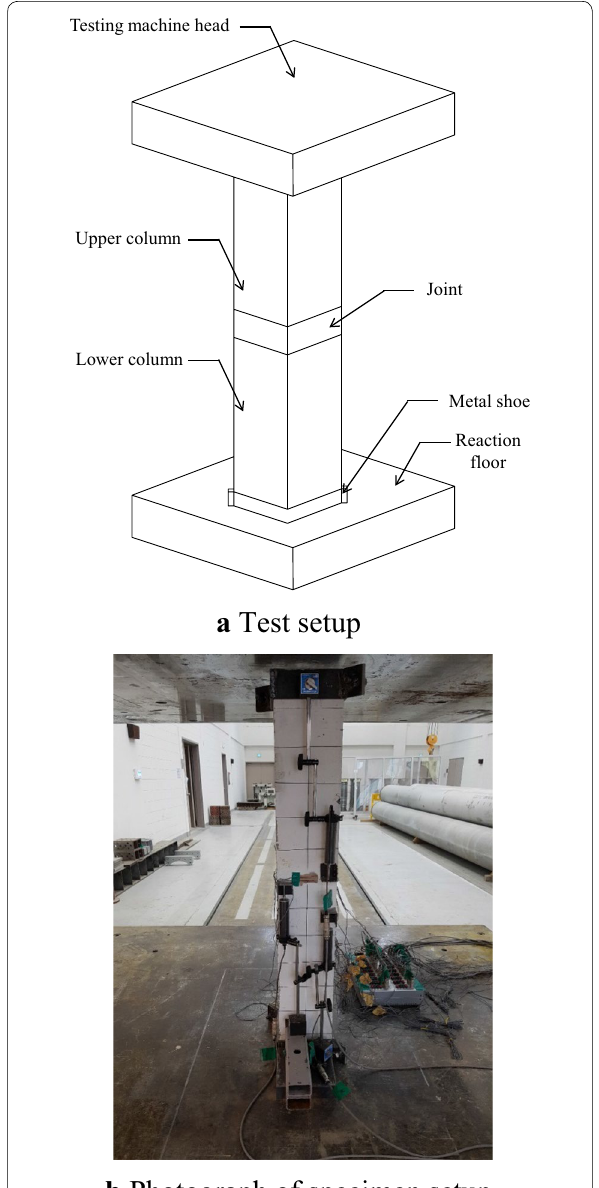
Fig. 5 Test setup.